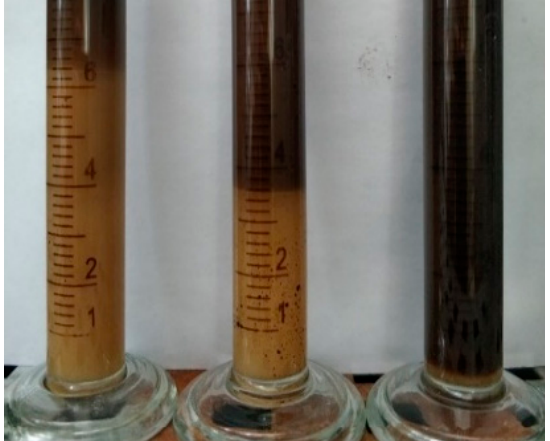
Figure 5. Emulsion states at different oil–water ratios at 48 h.